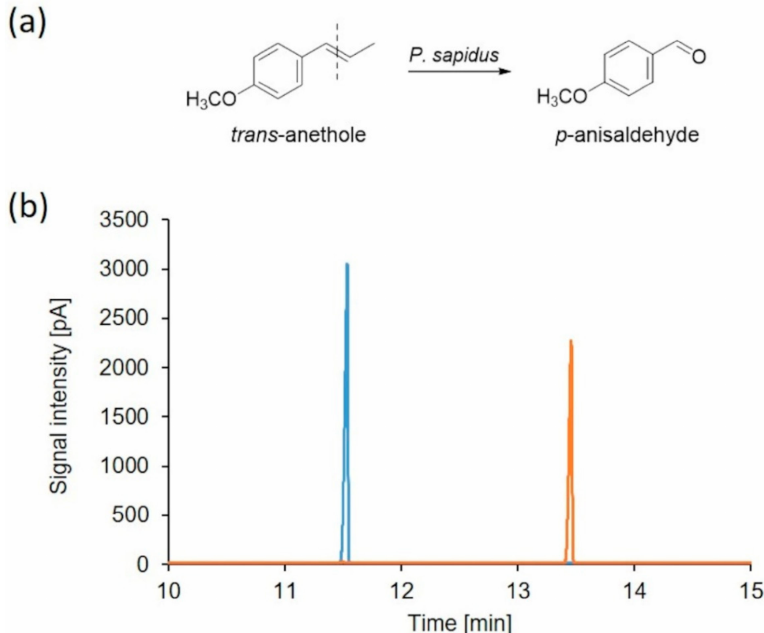
Figure 1. Bioconversion of trans -anethole by P. sapidus . ( a ) Alkene cleavage of trans -anethole resulted in the formation of p -anisaldehyde. ( b ) GC-FID chromatogram of an n -hexane extract of the conversion of the blank sample (blue) and after incubation with lyophilized mycelium of P. sapidus (orange). Retention times: trans -anethole (11.53 min) and p -anisaldehyde (13.45